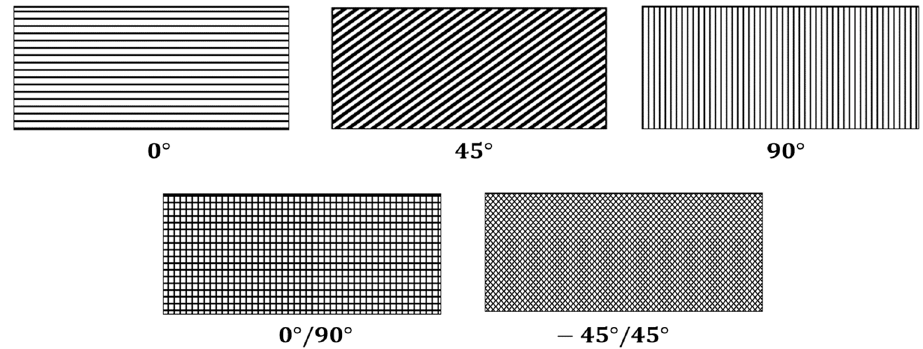
Figure 4. Raster orientation. 112